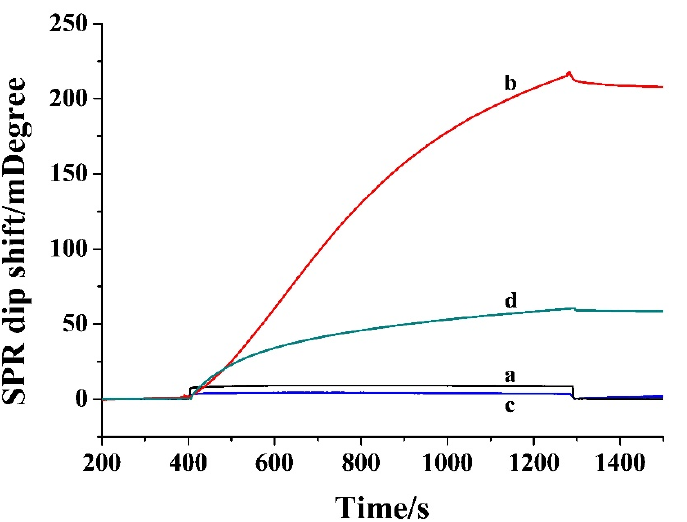
Figure 1. SPR sensorgrams when injecting 0.1 mg/mL SA-IgG to the fluidic channel wherein the NA-covered chip had been treated by blank buffer (curve a) and 20 nM bio-GDEVDGK-bio (curve b). Curves c and d were acquired when injecting 0.1 mg/mL IgG and 0.05 mg/mL SA onto the NA- covered chip treated by